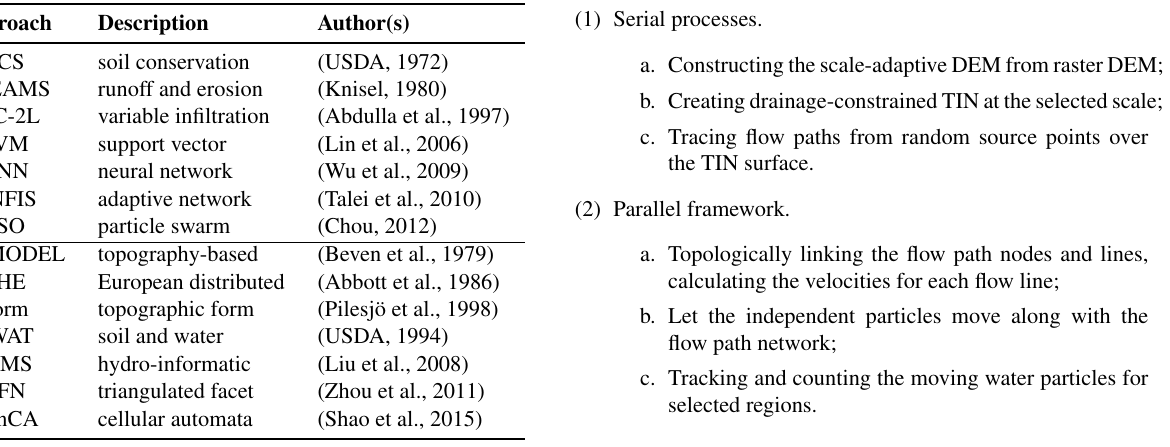
Table 1: The two main kinds of surface runoff models.